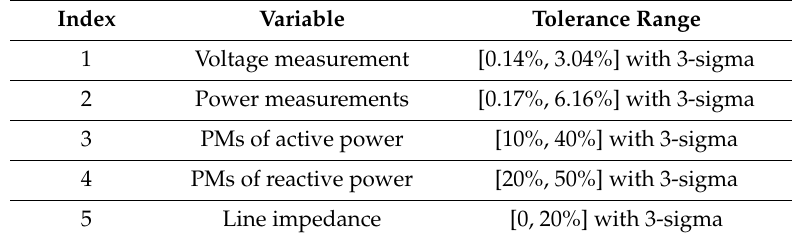
Table 1. Tolerance ranges for measurements and network variables [34]. PMs =